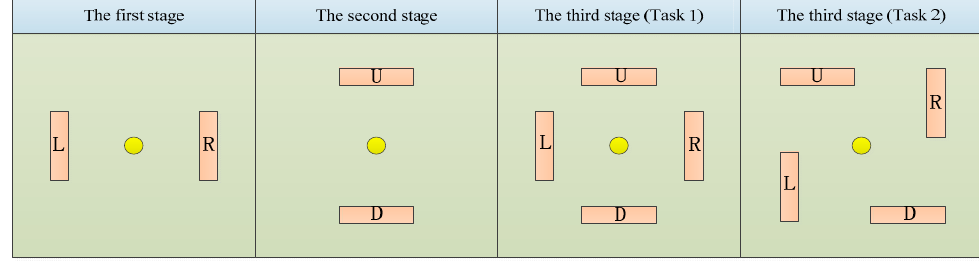
Figure 8. Cursor control tasks at different stages.